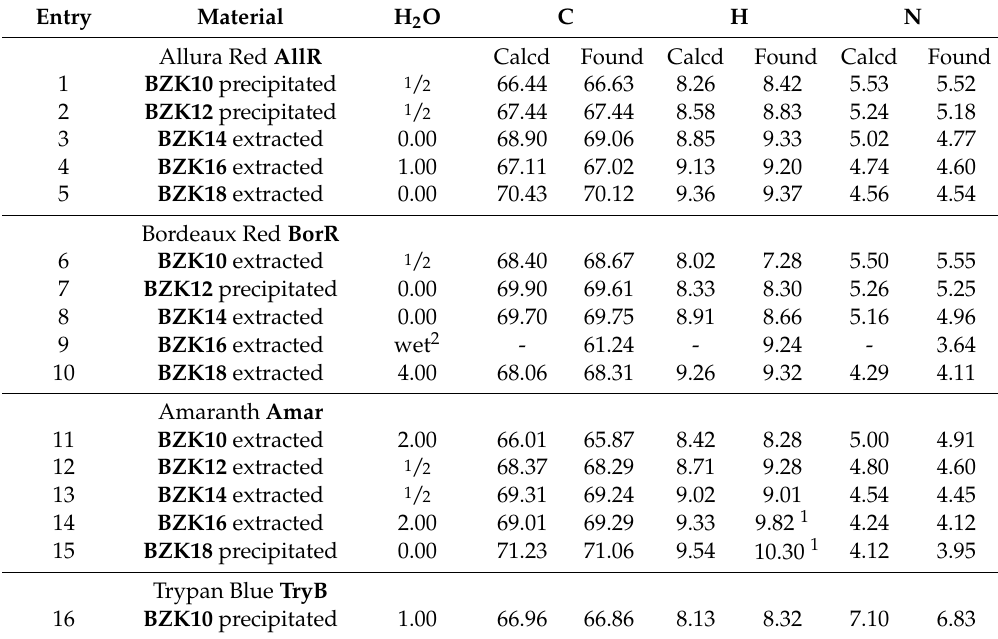
Table 1. Method of isolation and elemental analysis results for the 16 synthesized